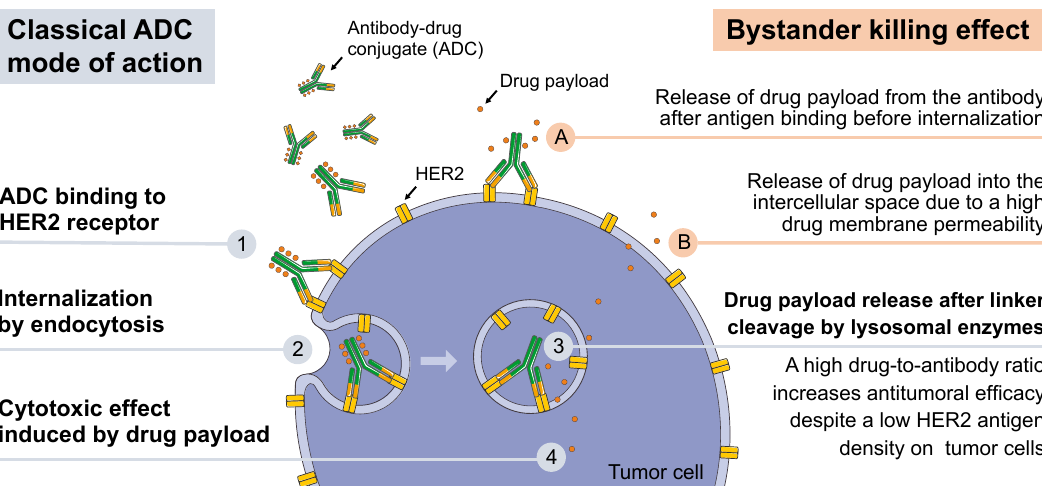
Figure 1. Mode of action of HER2 directed ADCs in HER2-low tumors. Classical mode of action of ADCs with cleavable linkers: (1) After binding of the monoclonal anti-HER antibody component to HER2 expressed on the cell surface of tumor cells, (2) the ADC-HER2 complex is internalized by endocytosis. (3) After linker cleavage by lysosomal proteases, the drug payload is released and (4) can induce the cytotoxic effect leading to tumor cell death. A high drug-to-antibody ratio can increase antitumoral efficacy despite a low HER2 antigen density on tumor cells. Bystander killing effect: Using cleavable linkers, ADCs can be designed to promote drug release from the target cell to the extracellular space. Thereby, surrounding and bystander cells, which may or may not express the ADC target antigen, can be killed by taking up the cytotoxic drug. (A) This bystander killing can occur if the cytotoxic drug is released from the antibody after antigen binding before internalization. (B) Additionally, the drug payload can be released from the tumor cell into the intracellular space